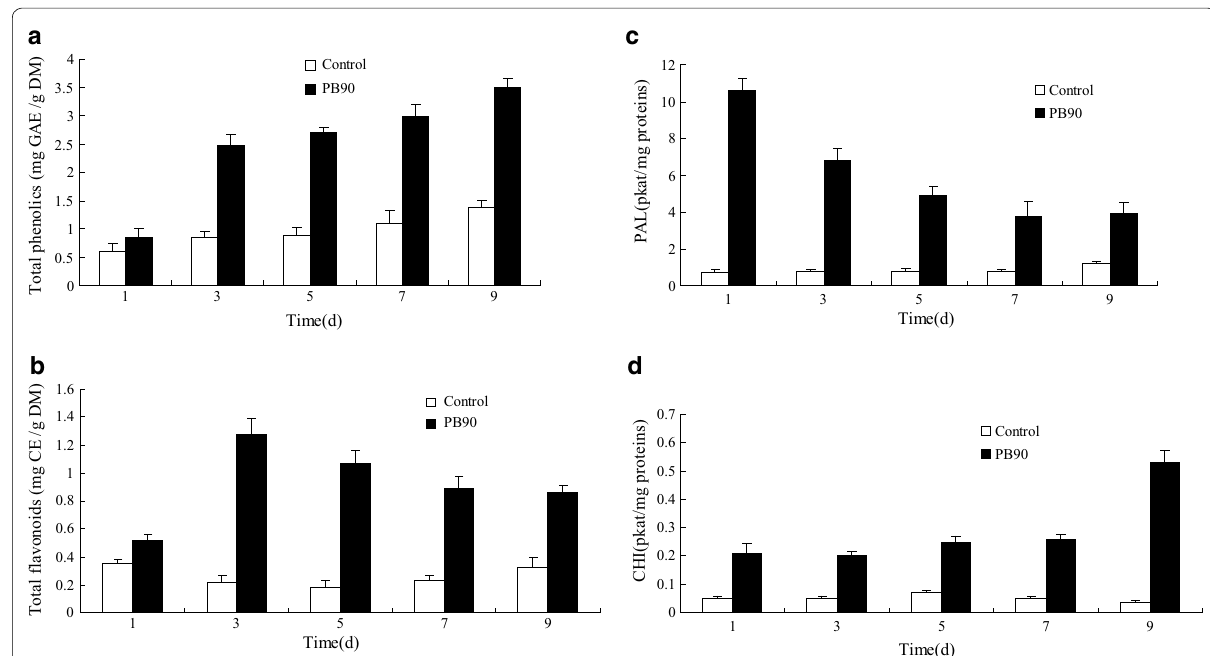
Fig. 3 Effects of PB90 on total phenolics ( a ), total flavonoids ( b ), the activity of PAL ( c ) and CHI ( d ) production. Tree-day-old cells treated with 5 nmol/L PB90 were harvested as the time indicated in the figure. The control received vehicle solvent only. The results shown are the average of five independent experiments. Bars represented standard